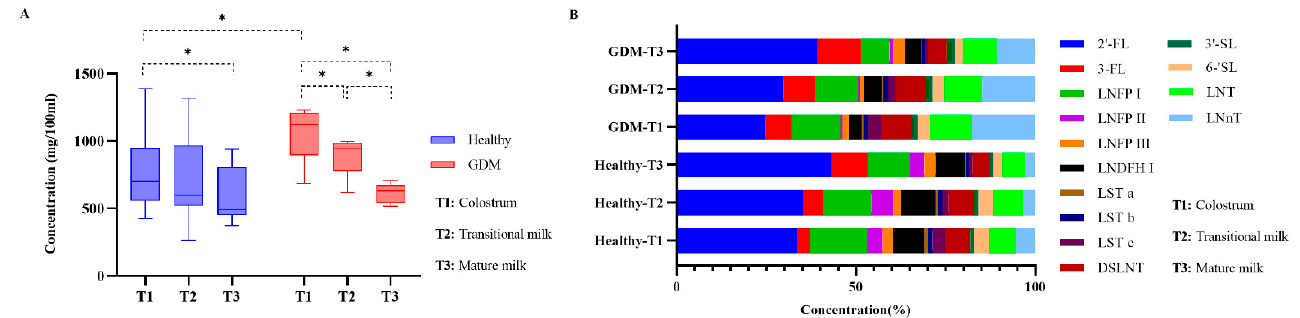
Table 2. Changes in various types of human milk oligosaccharides (HMOs) over time in Se + Le +